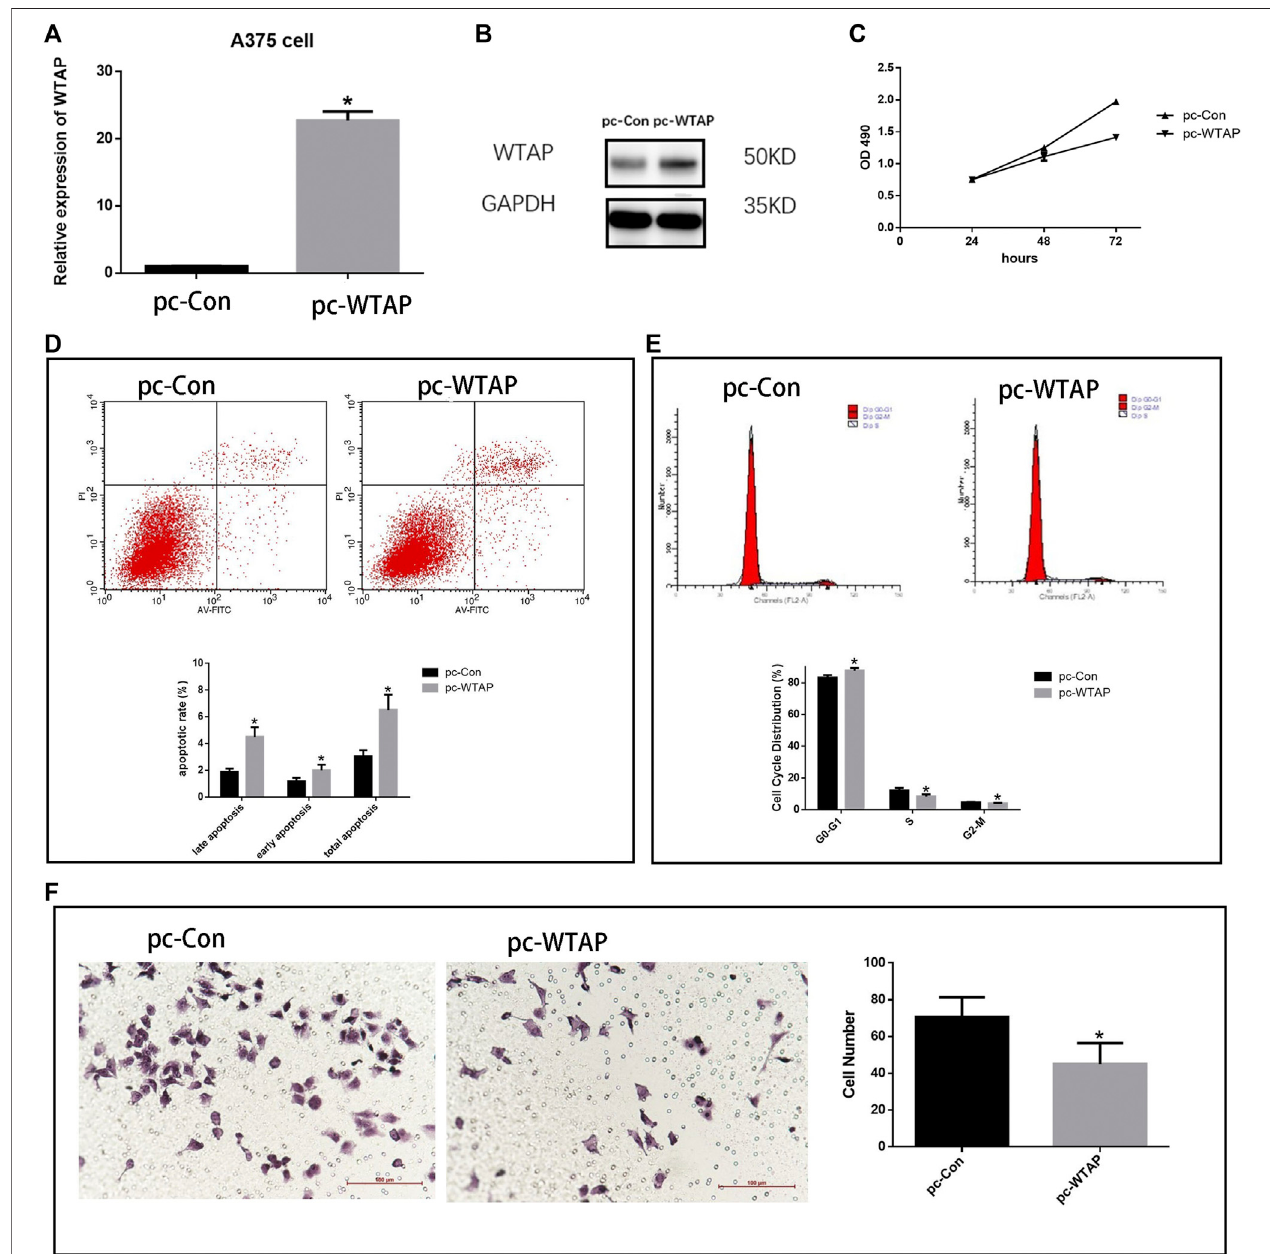
FIGURE 10 | Overexpression WTAP inhibited the aggressive behaviors of melanoma cells. (A) Plasmids transfected into A375 cells to overexpress the WTAP expression. The mRNA level of WTAP in A375 cell lines was detected by qRT-PCR. (B) The expression of WTAP in A375 cell lines was detected by western blotting (C) The proliferation of cells was detected by cell counting Kit-8 (CCK-8). (D) The apoptosis of A375 cells with WTAP overexpression (E) cell cycle of A375 cells was evaluated by fl ow cytometry. (F) Migration of A375 cells were detected by transwell assay.